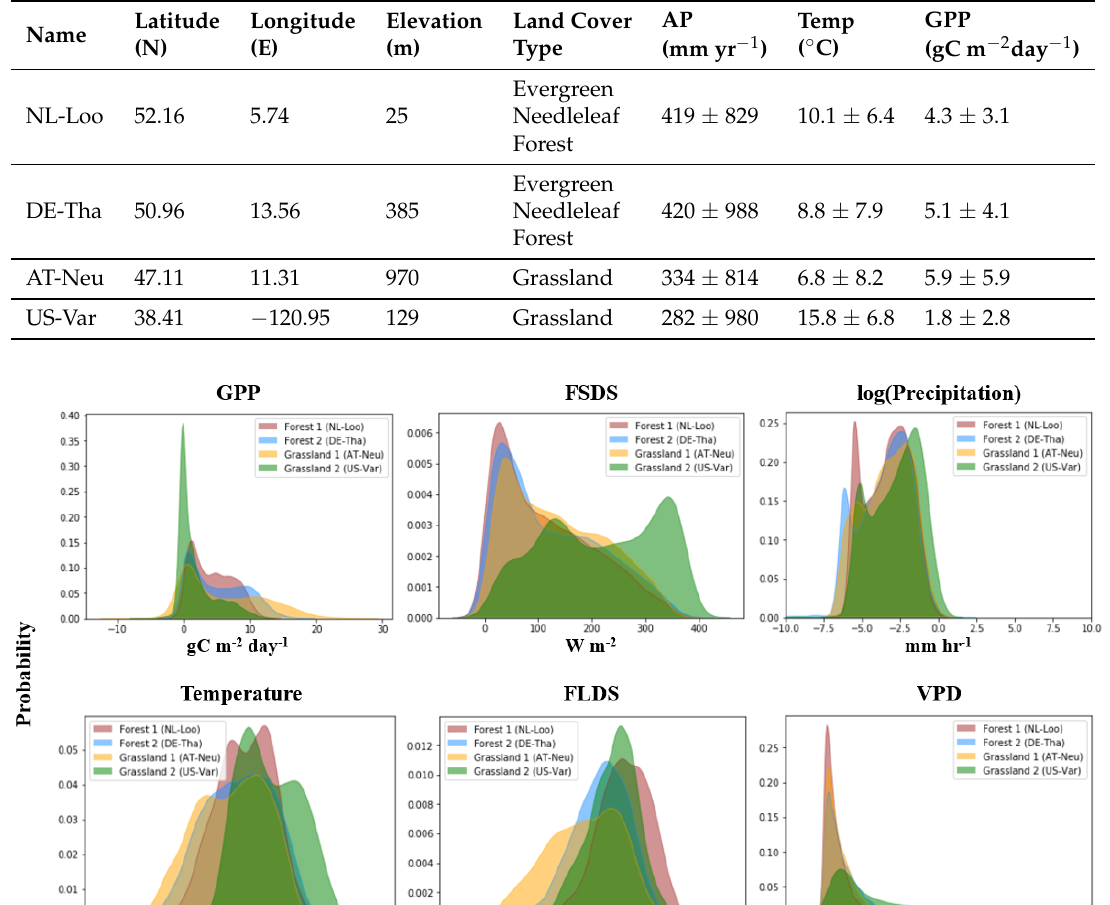
Table 1. Summary of the geographic location and basic information of the four FLUXNET sites included in this study. Time-varying data is represented in mean ± standard deviation. AP: annual precipitation.